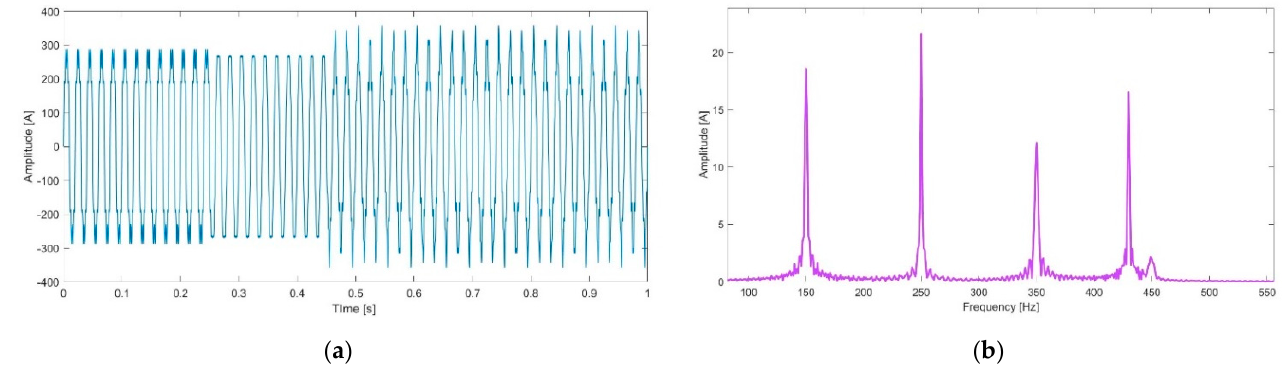
Figure 3. ( a ) Original digitized signal described in Table 1, ( b ) Discrete Fourier Transform (DFT) spectrum of the original signal-range 100 Hz to 550 Hz.